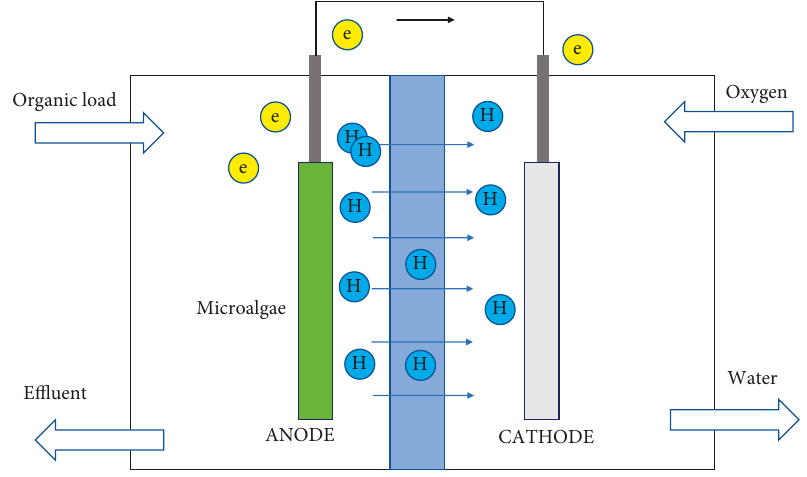
Figure 7: The working mechanism of